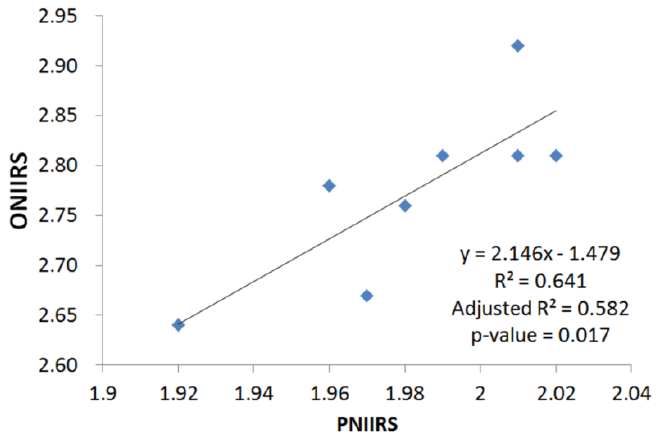
Figure 5. Linear regression analysis. The expression is y = 2.146 × x − 1.479, and a high correlation can be found in the R-squared value of 0.641; the adjusted R-squared is 0.582, and the p -value is